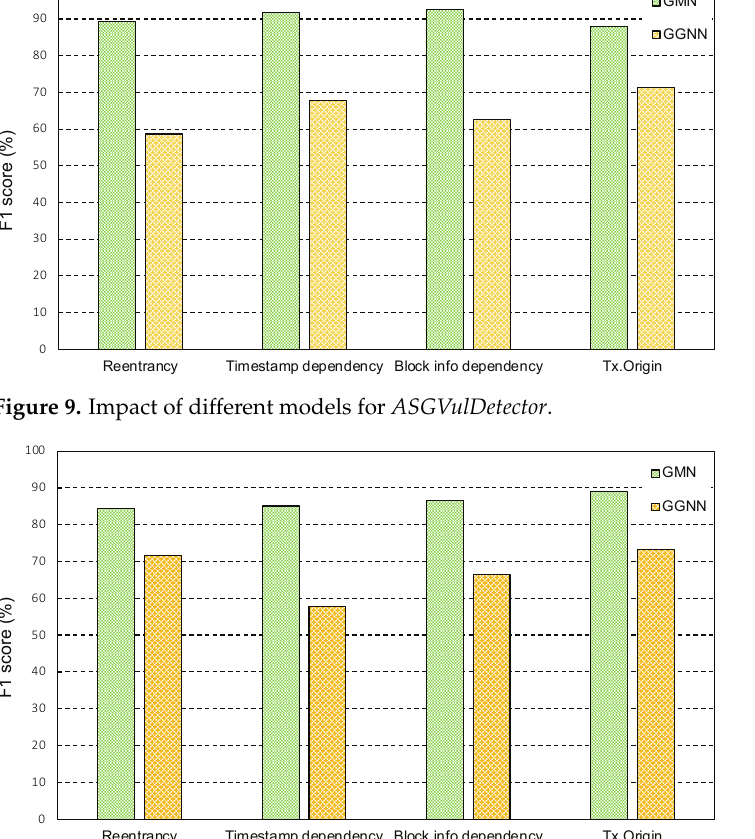
Figure 10. Impact of different models for BASGVulDetector